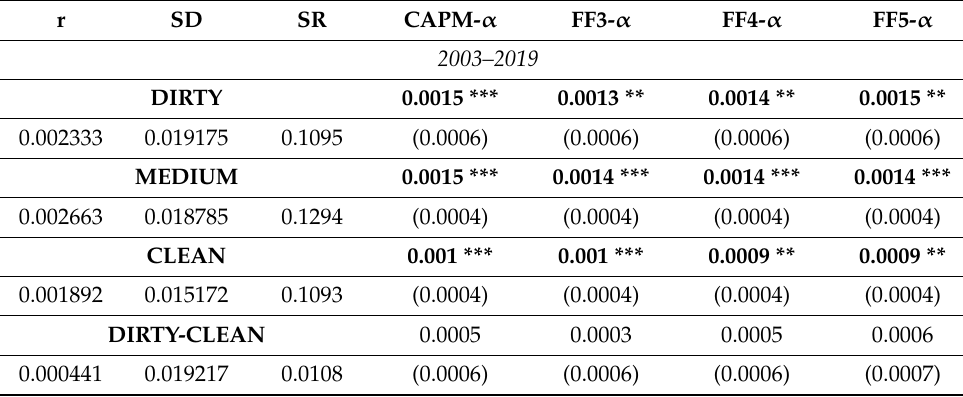
Table 1. Alpha coefficient and basic statistics for the period